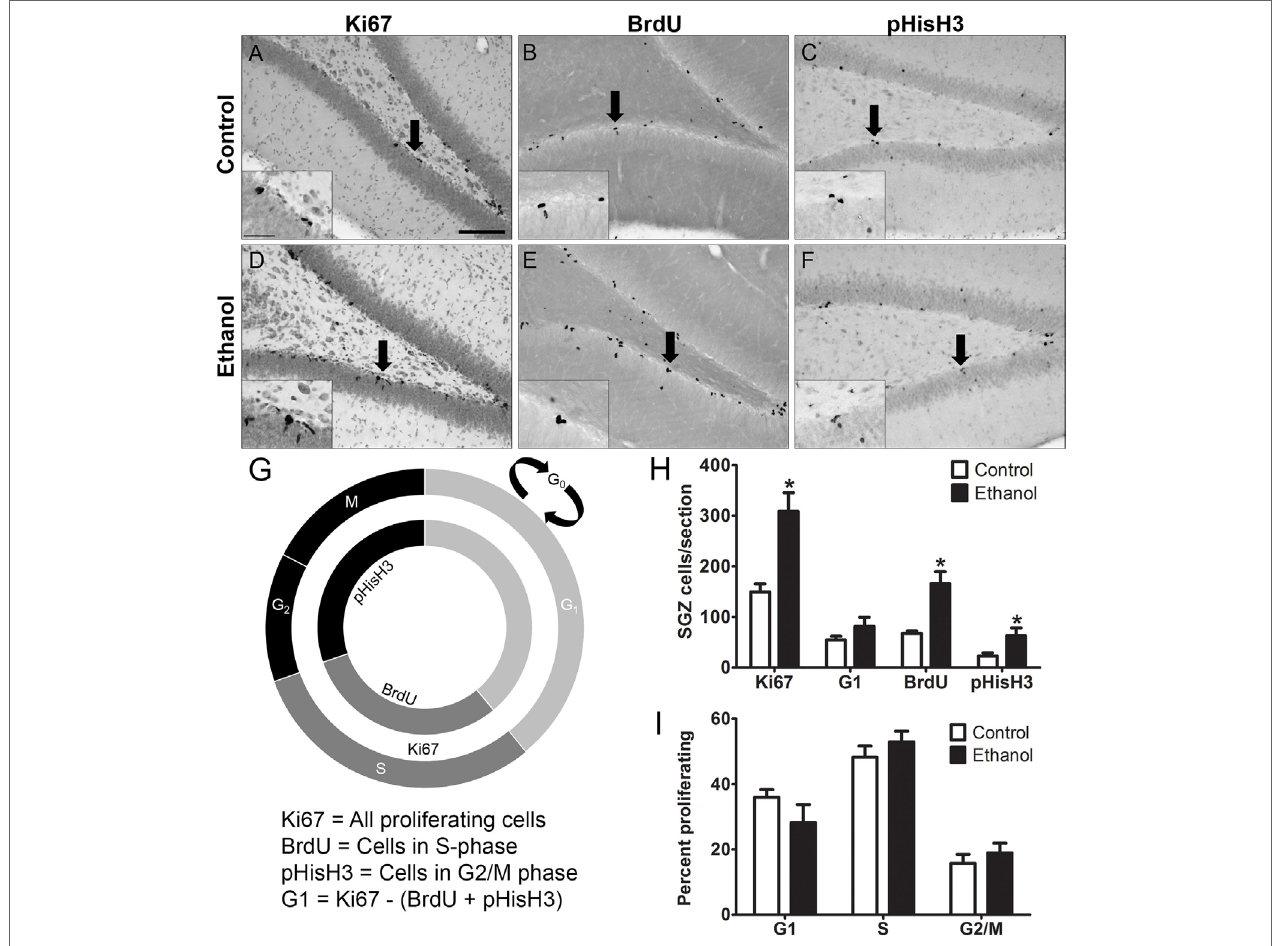
FigUre 2 | Binge ethanol exposure during adolescence and cell cycle distribution of subgranular zone neural progenitor cells (NPCs) at day 7 of abstinence. (a–F) Representative images from sections stained for Ki67, BrdU, and pHis-H 3 . Arrows denote area represented in the inset. (g) Cell cycle diagram showing the stages of the cell cycle labeled by Ki67, BrdU, and pHis-H 3 . BrdU labels cells in S-phase, pHis-H 3 labels cells in G 2 and M phase, and Ki67 labels actively dividing cells of all stages. G 1 population is calculated by subtracting total BrdU + and pHis-H 3 + cells from Ki67 + cell numbers. (h) Quantification data of dividing cells in Ki67 + (total), BrdU + (S phase), and pHisH 3 + (G 2 /M) cells. Calculated number of cells in G 1 was obtained by subtracting the number of BrdU + and pHisH 3 + cells from the number of Ki67 cells. (i) Calculated distribution of dividing NPCs within each phase of the cell cycle based on total number of Ki67 cells.